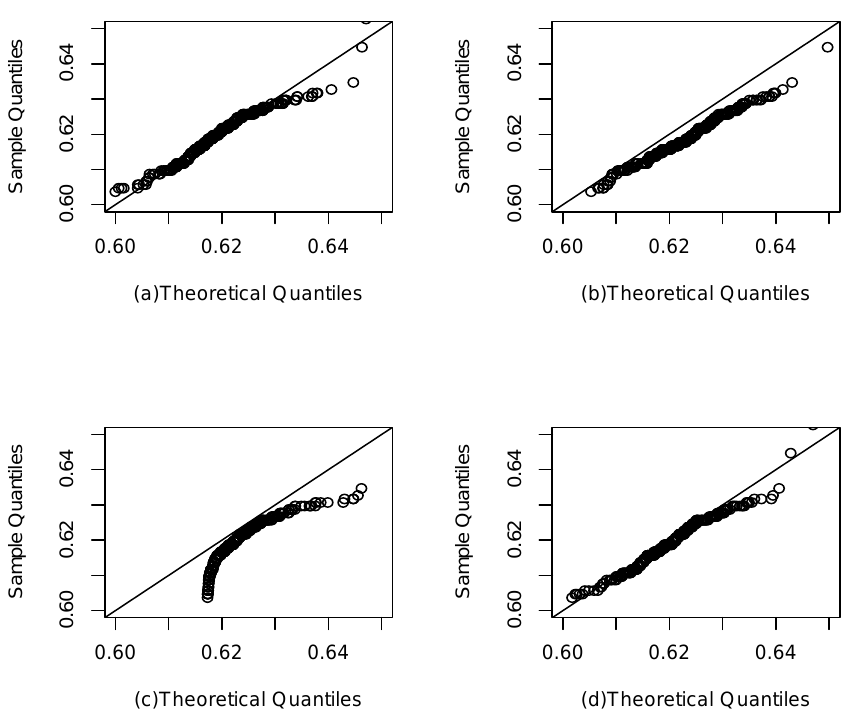
Figure 10. QQ plot for Nitrogen concentration data set. The density ML ( a ), EMLOG ( b ), EMG density ( c ), and EML ( d